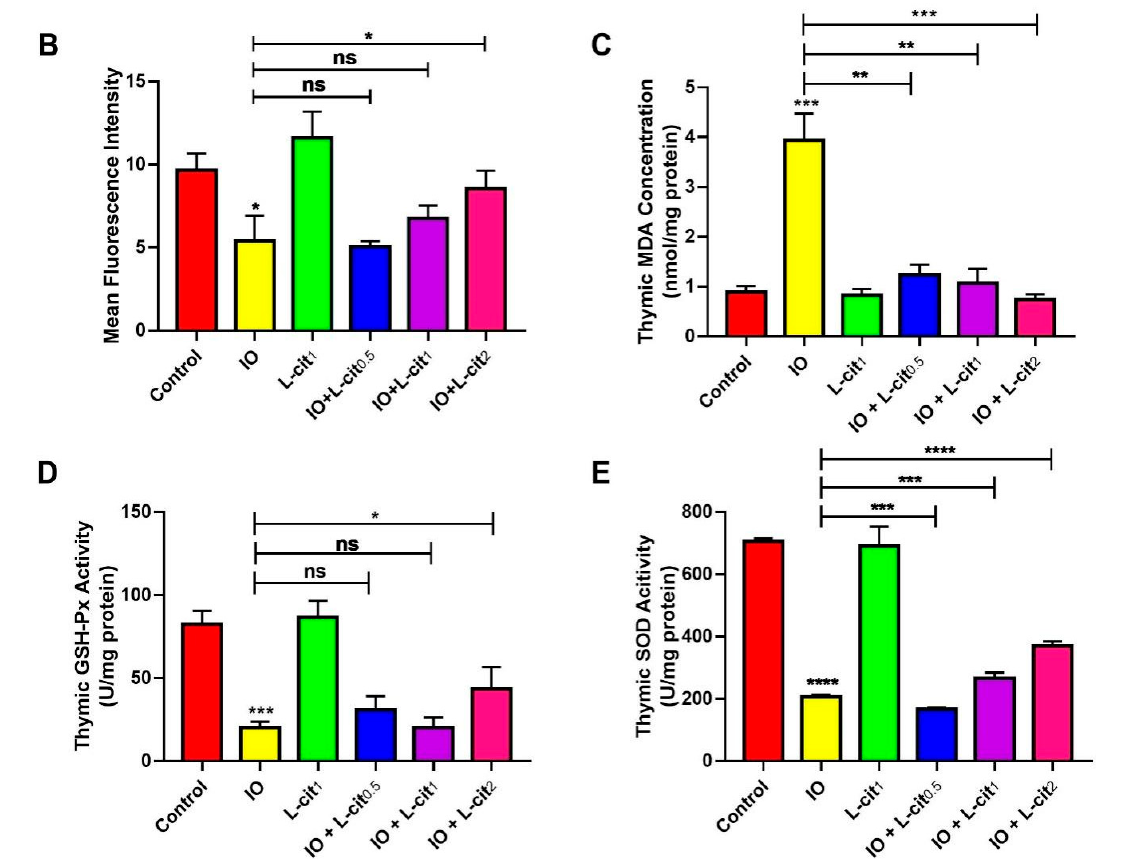
Figure 2. L-cit attenuates oxidative stress induced by iron overload in mouse thymus. Mice were intraperitoneally injected with iron dextran 50 mg/kg, and L-cit was given by gavage administration with a dosage of 0.5, 1.0, and 2.0 g/kg/day. ( A , B ) CD8 + T-lymphocytes determined by immunofluo- rescence assay. ( C ) MDA concentration. ( D ) GSH-Px activity. ( E ) SOD activity. Values represent mean ± SEM. of three independent experiments. Significant differences are represented by * p < 0.05, ** p < 0.01, *** p < 0.001, **** p < 0.0001, ns (not significant).